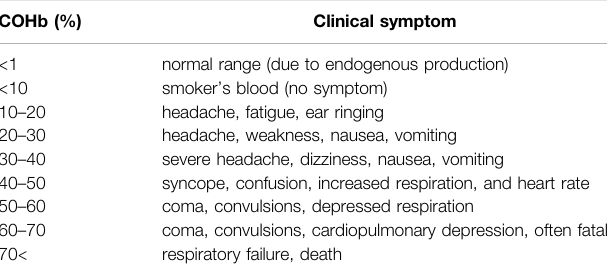
TABLE 1 | Levels of carboxyhemoglobin (COHb) saturation (%) and symptoms (Kinoshita et al., 2020). COHb (%) Clinical symptom <